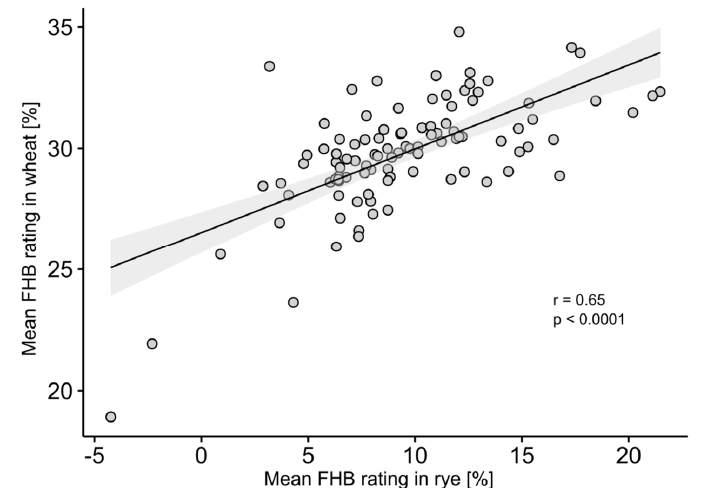
Figure 3. Relationship between wheat and rye calculated as BLUES with mean Fusarium head blight (FHB) rating of 100 Fusarium culmorum isolates across four environments; indicated is the regression line and the standard deviation (in grey); r = coefficient of correlation, p = probability of error.